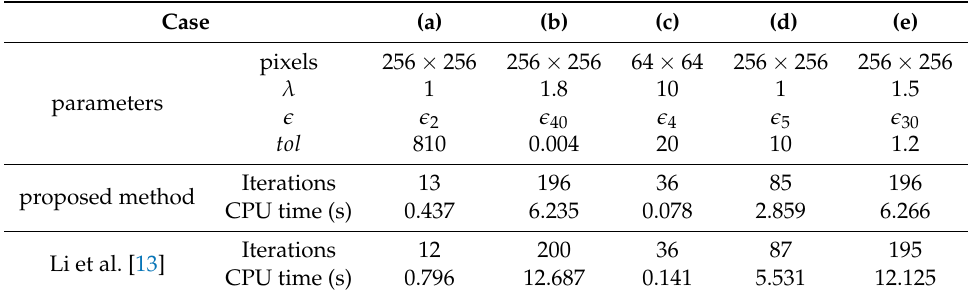
Figure 10. Rice image with salt-and-paper noise segmentation. From left to right columns, the noise density level are 0.01,0.1,0.2. ( a ) Original image with noise and numerical results by ( b ) previous method in [20] and ( c ) proposed method used λ = 100,200, 300 according to each noise density level 0.01,0.1,0.2, respectively. Table 1. Comparison of performance between our proposed method and previous method in